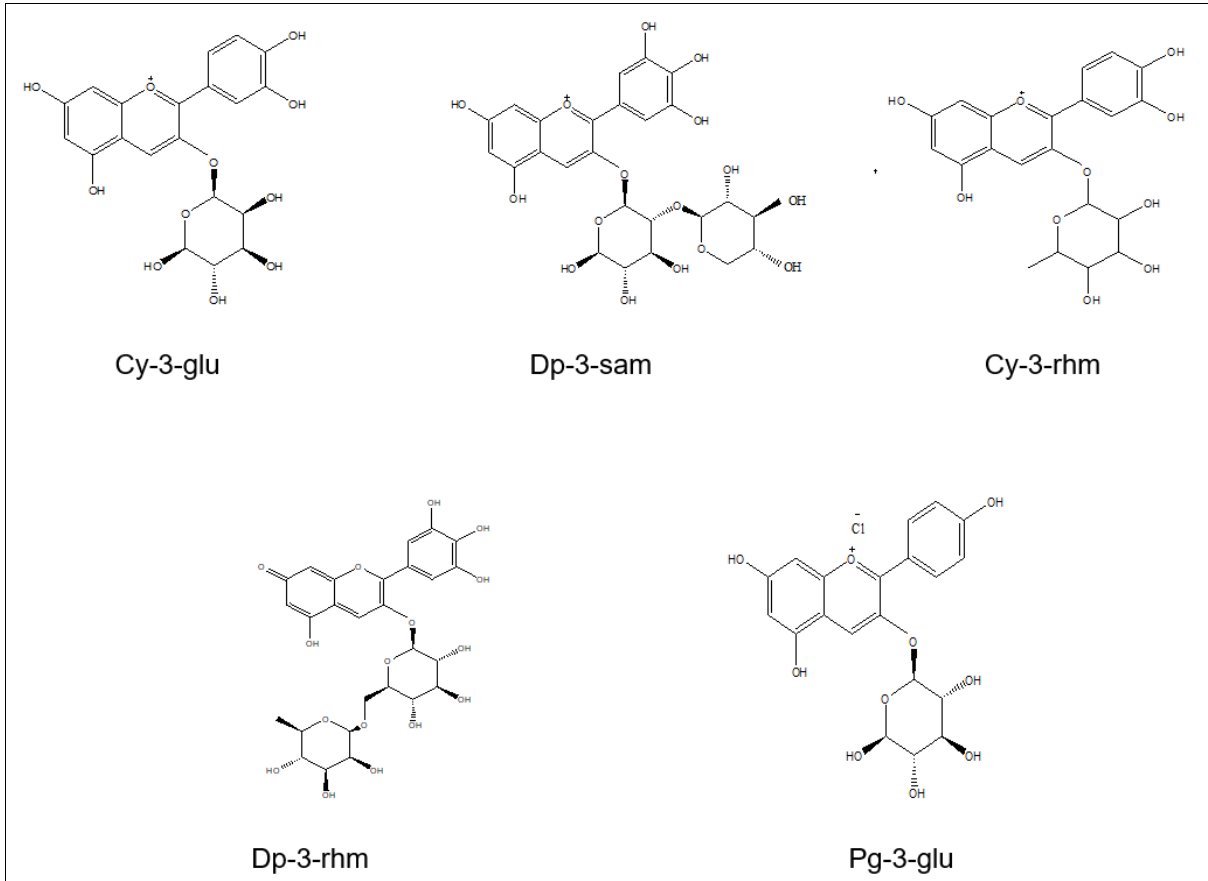
Figure 2: Chemical structures of the anthocyanin